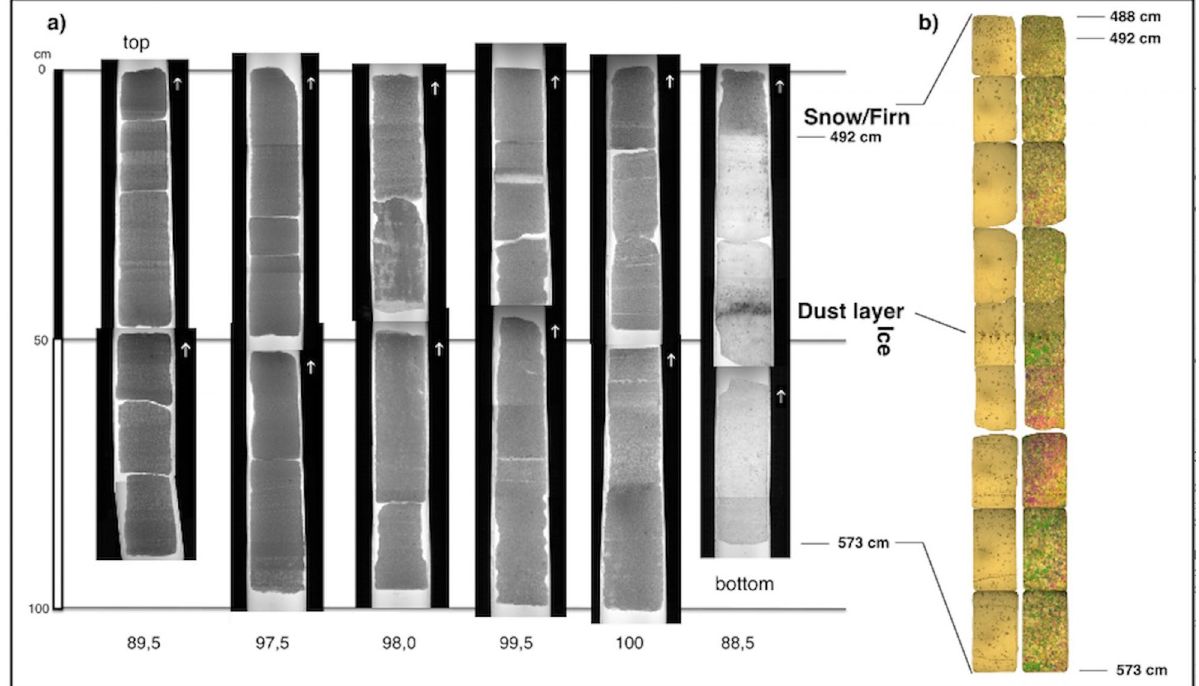
Figure 1. Ice core stratigraphy. ( a ) Visual stratigraphy of drilled ice core under transmitted light: below each section the total length of the single run is reported, from the top (upper left) to the bottom run (lower right). ( b ) Thin sections of the bottom part of the core with ice facies; on the left, the single polarizer images which highlight the air bubble size and density; on the right, crossed polarization filters which show ice crystal structure and size, and crystal boundaries. The sections correspond from left to right to DNA metabarcoding samples P1 to P6.